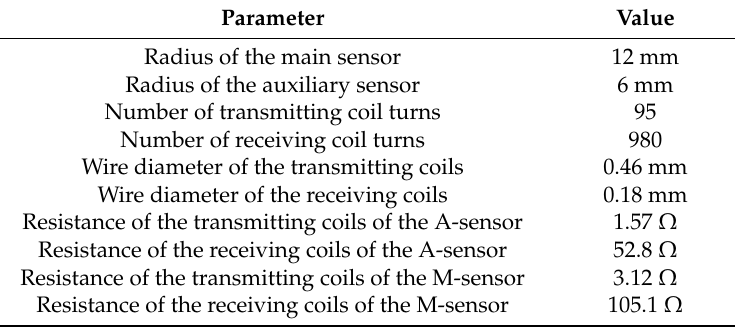
Table 1. Sensor parameters for the nondestructive inspection (NDI) of multipipe